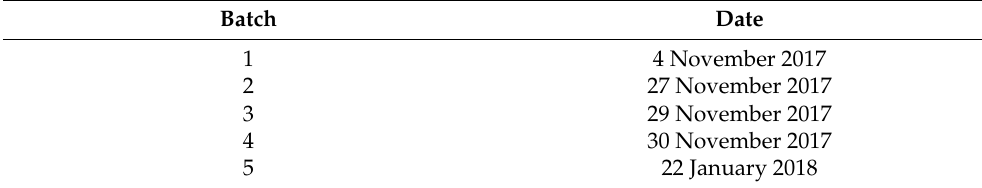
Table 3. Batches of high-strength glass fibre composites